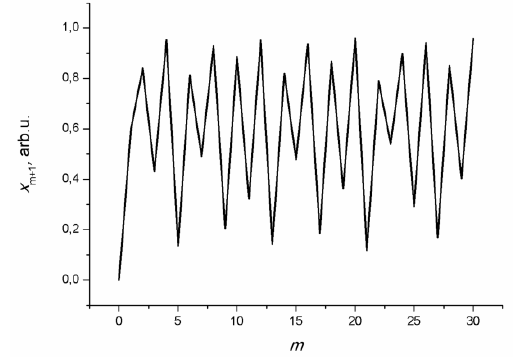
Fig. 3. Plot of the dependence of the function 1 + m x on m (number of generations), that characterizes the kind of cycles S occurring in the dynamic linguistic system: in the PC linguistic community, chaos begins to